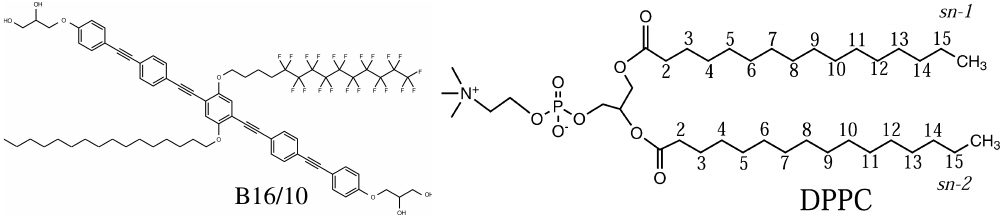
Figure 1. Molecular structure of the polyphilic molecule B16/10 and dipalmitoylphosphatidylcholine (DPPC) molecule studied in this